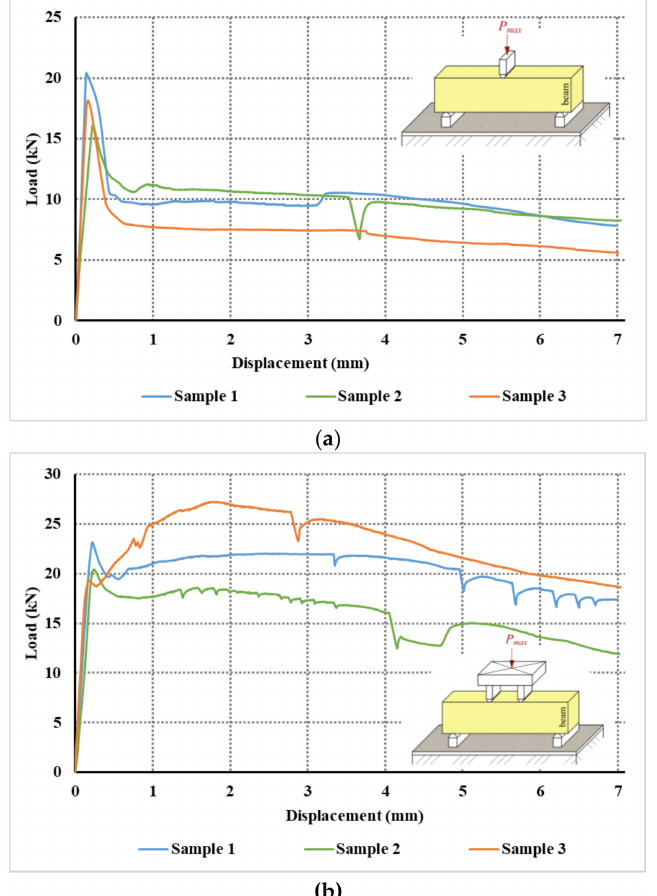
Figure 6. Load–displacement diagrams for: ( a ) three-point bending test; ( b ) four-point bending